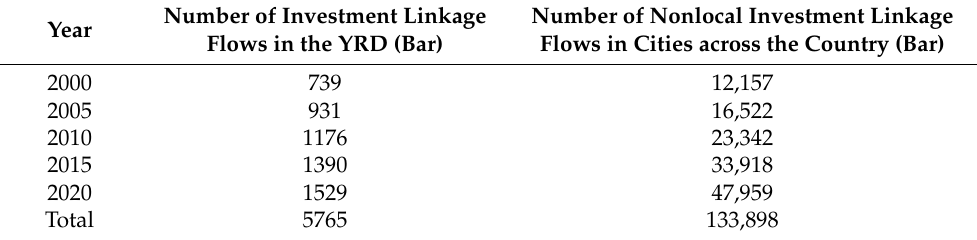
Table 1. The basic situation of investment linkage flows between cities in different places. Number of Investment Linkage Number of Nonlocal Investment Linkage Year Flows in the YRD (Bar) Flows in Cities across the Country (Bar) 2000 739 12,157 2005 931 16,522 2010 1176 23,342 2015 1390 33,918 2020 1529 47,959 Total 5765